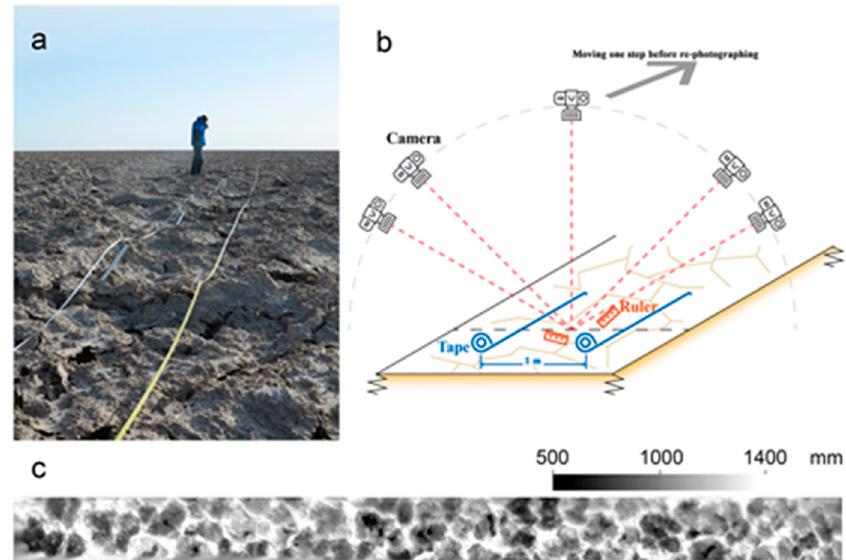
Figure 2. ( a ) Photo of field work, ( b ) schematic fieldwork map, and ( c ) digital elevation model (DEM) of a typical honeycomb salt crust. Our imaging sequence was as follows: (1) Two tapes (blue in the diagram above) were placed on the ground to mark out a NW-to-SE orientation; (2) Rulers (orange) were placed randomly between the tapes; (3) Photos were taken at zenith angles between 0° and 45°, starting at one tape endpoint; (4) Photos were taken step-by-step along the tapes; and (5) Steps (3) and (4) were continued until the end of each tape. Polygonal uplifts are very clear in the DEM created with the reconstruction workflow.